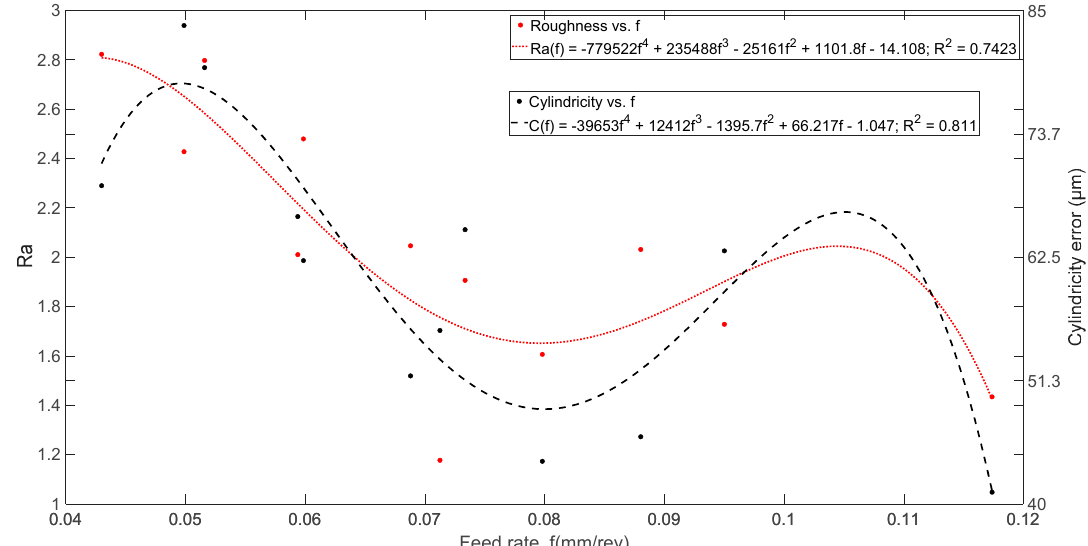
Figure 9. E ff ects of feed rates [mm / rev] on average roughness ( Ra ) and cylindricity. Figure 9. Effects of feed rates [mm/rev] on average roughness ( Ra ) and cylindricity. Table 6. Cylindricity Model Summary.